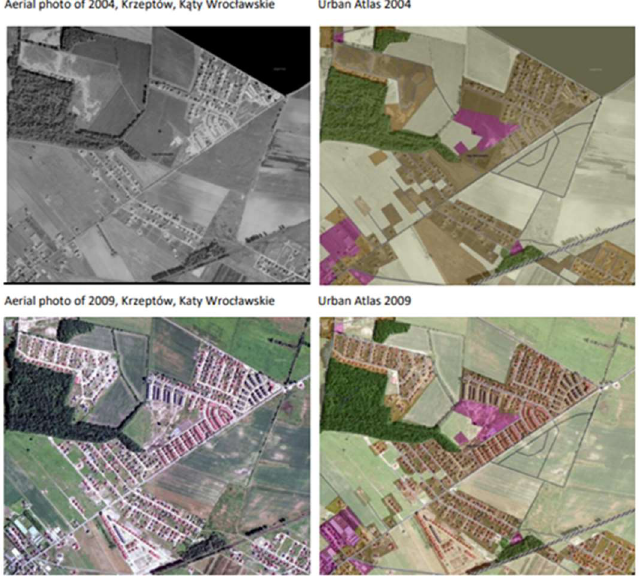
Figure 9. Comparison of aerial photographs of the Urban Atlas database. Resources: P. Mal- czewski, Institute of Territorial Development in Wroclaw.